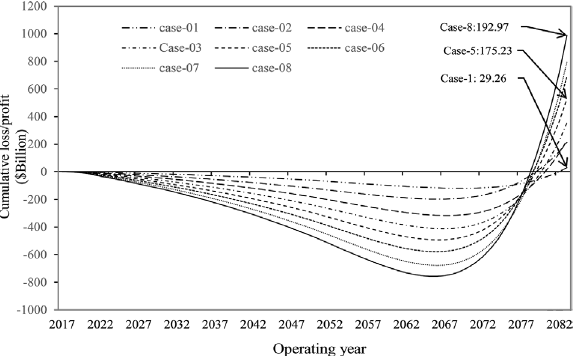
Figure 13. Illustrative retained earnings at eight different case studies of the Rooppur NPP